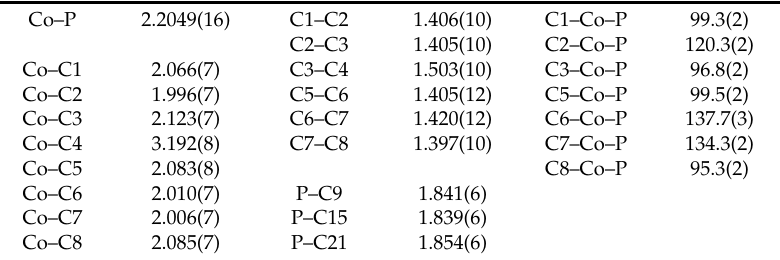
Table 1. Selected X ‐ ray Bond Lengths (Å) and Angles (°) for complex 1 . Table 1. Selected X-ray Bond Lengths (Å) and Angles ( ◦ ) for complex 1